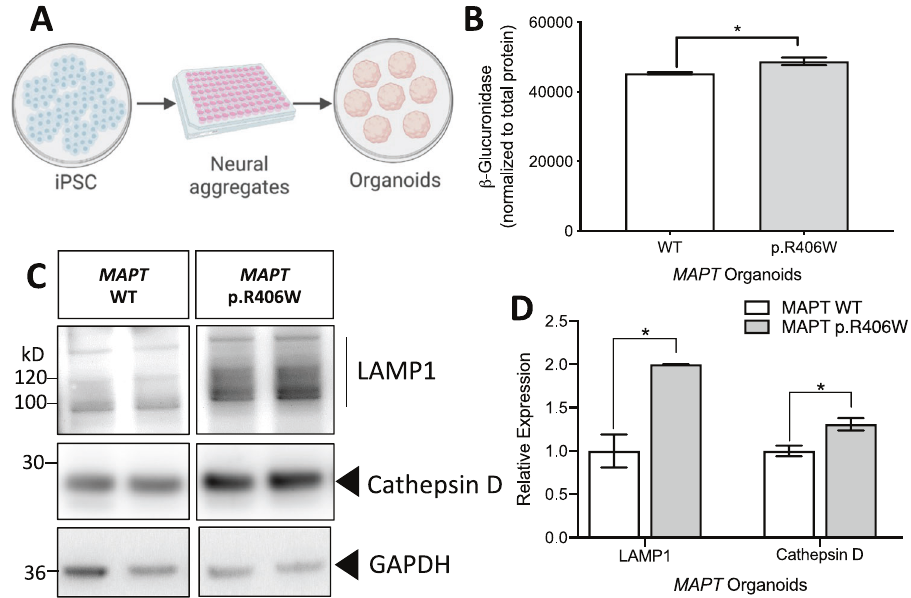
Fig. 7 MAPT p.R406W organoids phenocopy lysosomal defects. A Schematic of organoid generation. iPSC from a MAPT mutation carrier and CRISPR/Cas9-corrected control (wild-type (WT)) were differentiated into cortical organoids and cultured for 2 months. B Enzyme activity of β -Glucuronidase measured in organoid lysates (10 μ g protein) from MAPT p.R406W and corrected control organoids. Enzymatic activity was normalized to total protein. Graphs represent mean ± SEM. C Immunoblots of cell lysates from organoids were probed with LAMP1 and Cathepsin D (active form shown) antibodies. D Quanti fi cation of protein analyte levels in the MAPT p.R406W organoids and isogenic controls. Graphs represent mean ± SD. Signi fi cance was determined using an unpaired, t- test. * p < and pathology [11 – 13]. It has been shown that overexpression of brain tissue homogenates [46]. This increase could re fl ect changes TFEB in mouse models of tauopathy (PS19 and rTg4510) activates in neurons and glia. Similarly, we found that TFEB transcript levels the lysosomal pathways, leading to reduced tau aggregation and were elevated in the MAPT p.R406W brain tissue. TFEB promotes lipofuscin granules and restored synaptic function [12, 13]. TFEB expression of lysosomal genes and autophagosome formation has also been shown to play an essential role in mediating [37, 49, 65], and many of these genes are also differentially lysosomal-mediated exocytosis and spreading of tau [66]. expressed in MAPT p.R406W brains. Modulation of lysosomal Additionally, reduced expression of ATG genes suggest that pathways in mouse models of tauopathy modi fi es tau clearance